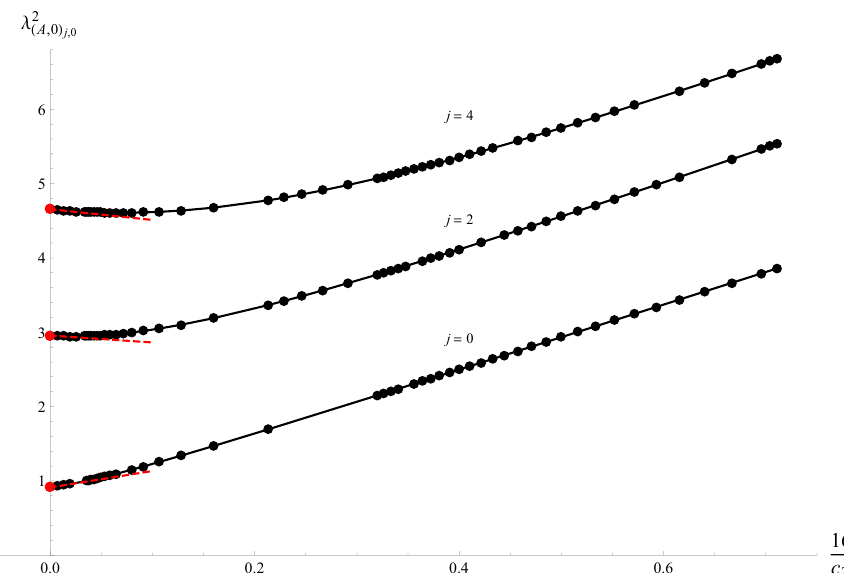
Figure 5 . The (cid:21) 2 OPE coe(cid:14)cients for the three lowest spins in terms of the stress-tensor ( A; 0) coe(cid:14)cient c T , where the plot ranges from the generalized free (cid:12)eld theory limit c T ! 1 to the numerical point 16 (cid:25) : 71 where (cid:21) 2 = 0. The red dots denotes denote the known values at the ( B; 2) c T generalized free (cid:12)eld theory points given in table 3, while the red dotted lines show the linear (cid:12)t for large c T given in (5.5). These bounds were computed with (cid:3) =